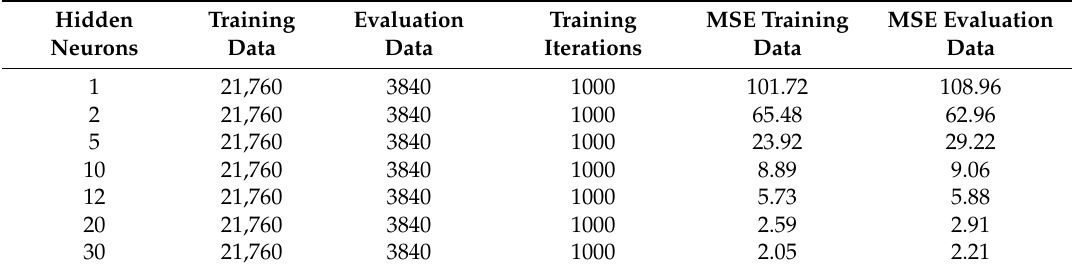
Table 3. Results of network trainings with different number of neurons in the hidden layer. Hidden Training Neurons